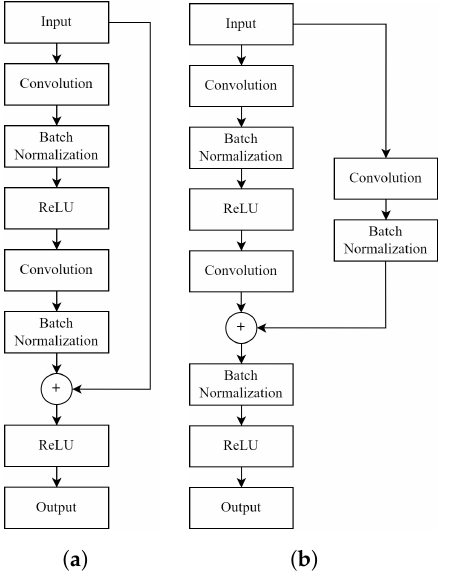
Figure 2. ( a ) Residual connection design from the ResNet. ( b ) Residual connection design imple- mented in the